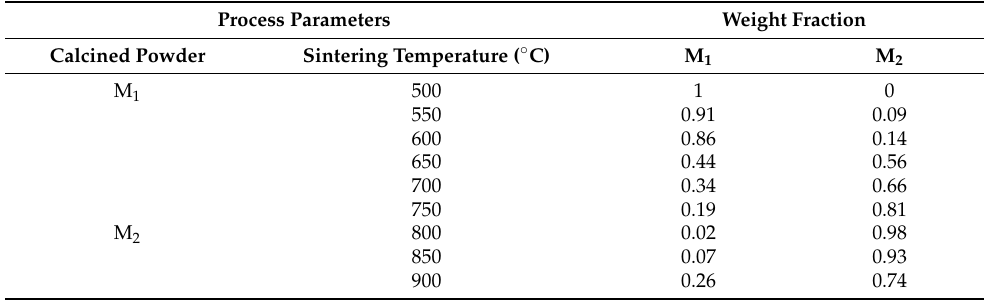
Table 2. The transformed mole fraction of M 1 and M 2 samples sintered at various